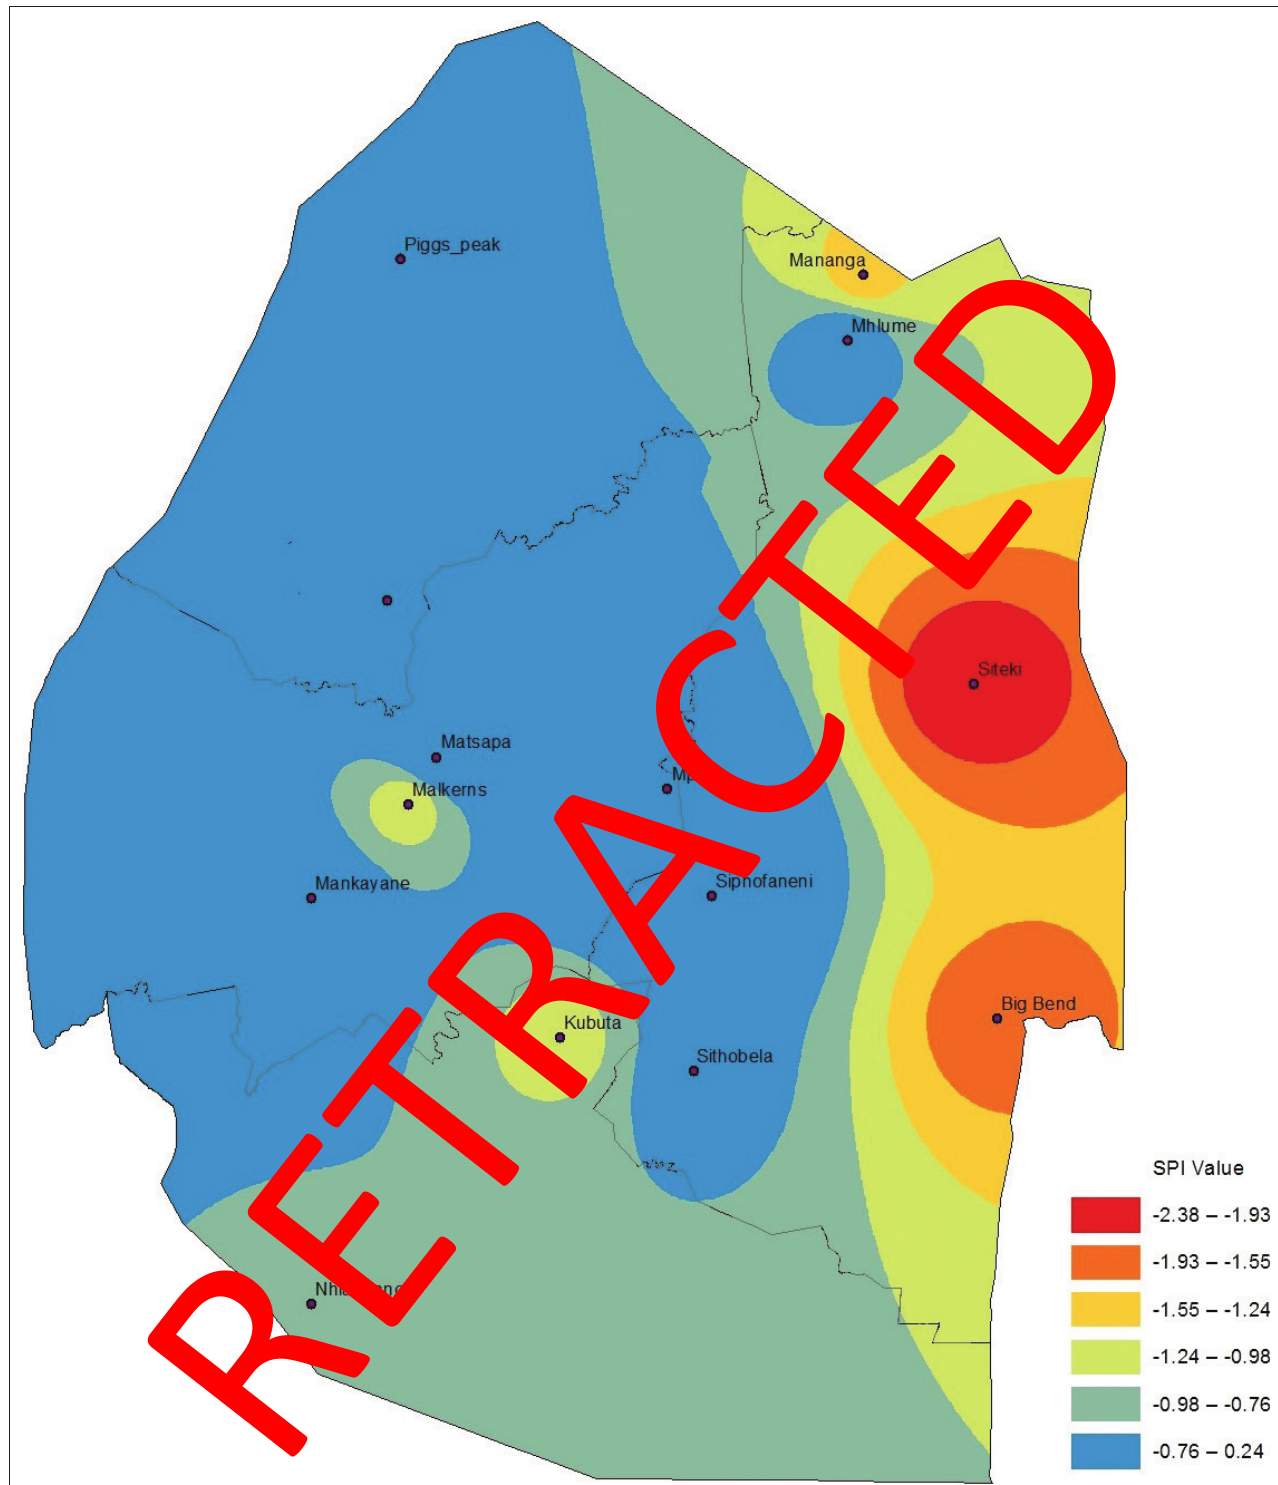
FIGURE 6: Standard Precipitation Index 3-month timescale during